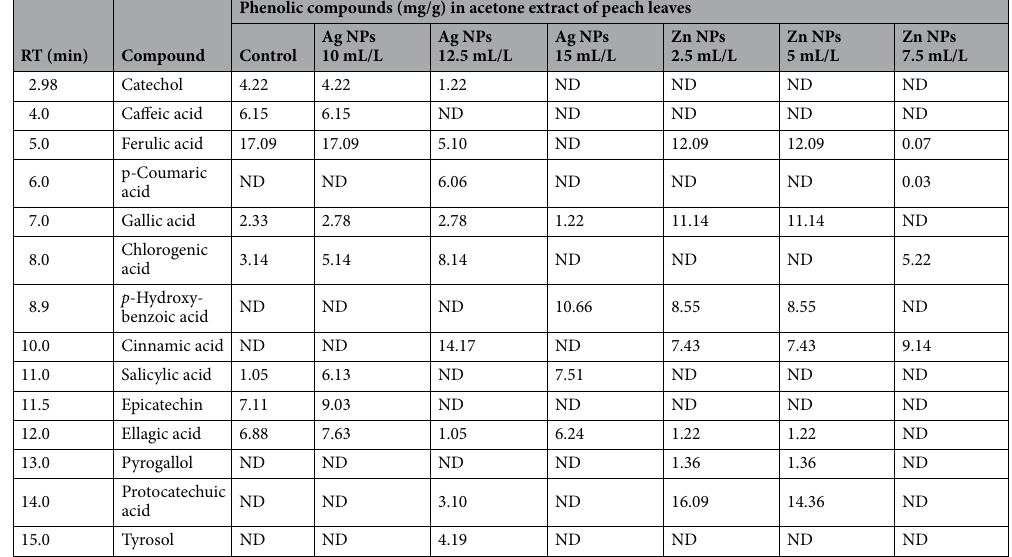
Table 7. HPLC analysis of phenolic compounds in leaves of peach ( Prunus persica L. Batsch). ND not